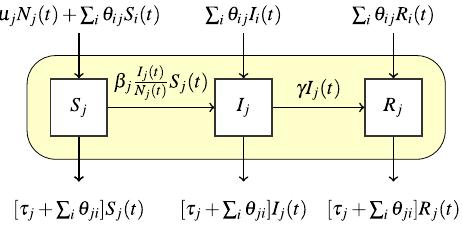
Figure 1. Schematic representation of the intra-herd epidemic-demographic dynamics for a herd j , without any control measure. Horizontal arrows represent transitions between health-related compartments, corresponding to the course of infection inside the herd (yellow rectangle), while vertical arrows represent population flows to and from the herd. The coefficients on the arrows are the transition rates. See main text in “Methods” for parameter